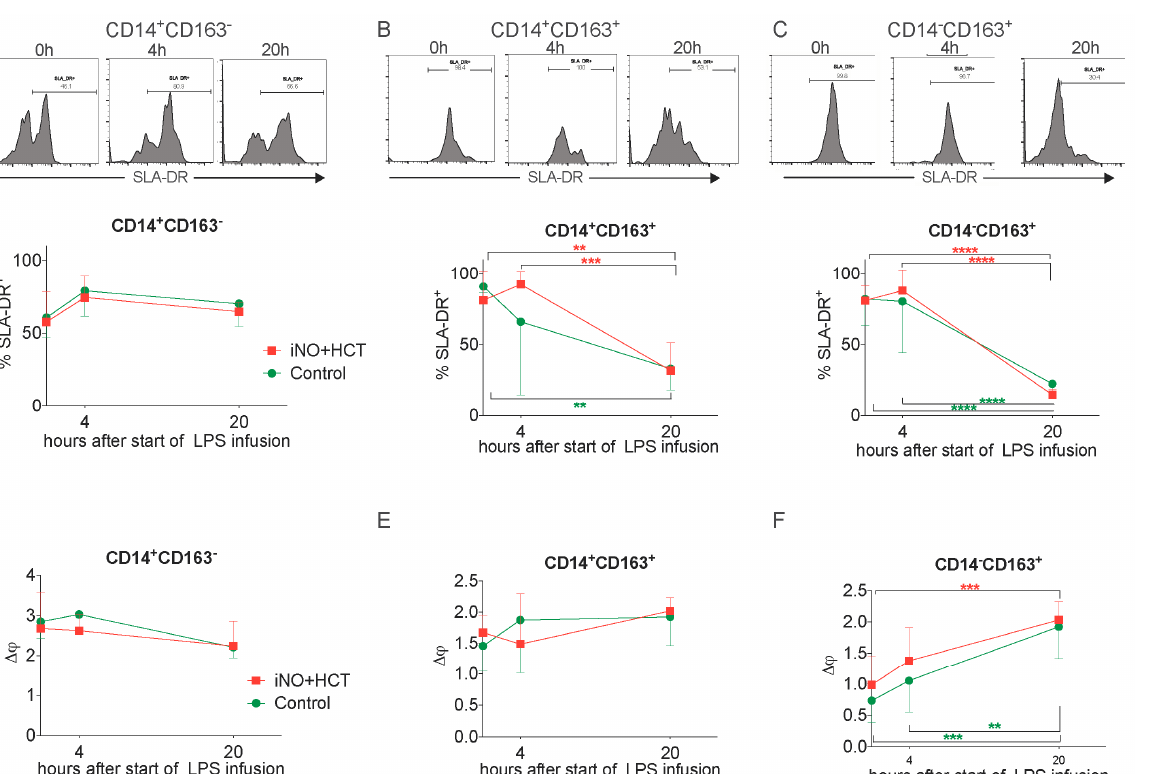
T-cells. ( D ) Representative dot plots of the flow cytometric analysis of blood monocytes; first, all cells were gated, and then the gate for the MNCs was applied and this population was analyzed for the expression of CD163 and CD14 before the infusion of endotoxin, 4 h and 20 h after the start of endotoxemia. The frequency of: ( E ) CD14 + CD163 − monocytes, ( F ) CD14 + CD163 + monocytes, and ( G ) CD14 − CD163 + monocytes is shown. Mean values ± SD are presented. Baseline, T4 h T8